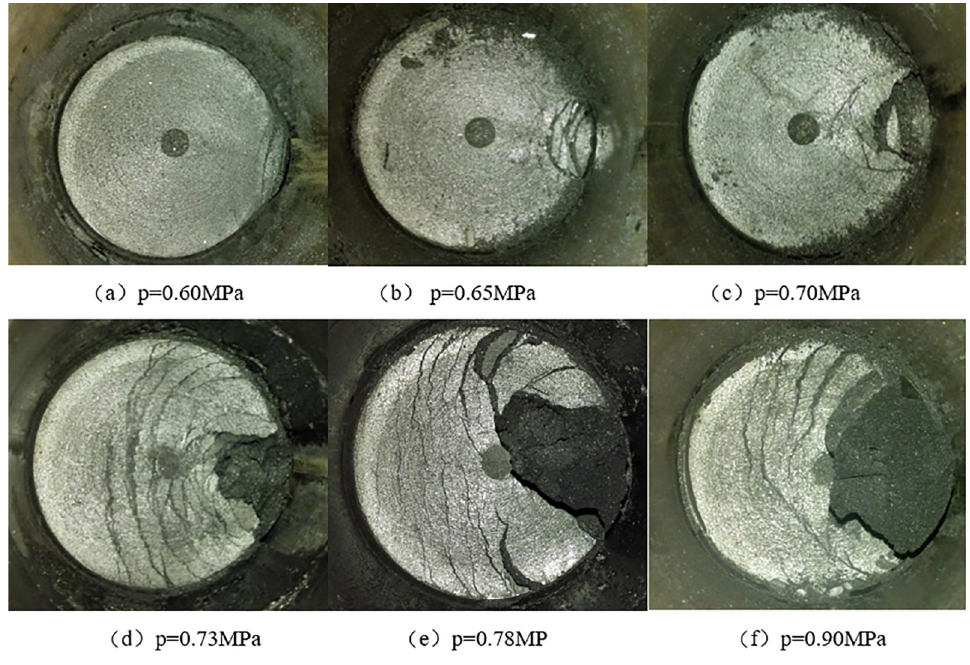
Fig 5. Damage degree of the coal samples under different adsorption pressures after rapid pressure unloading.